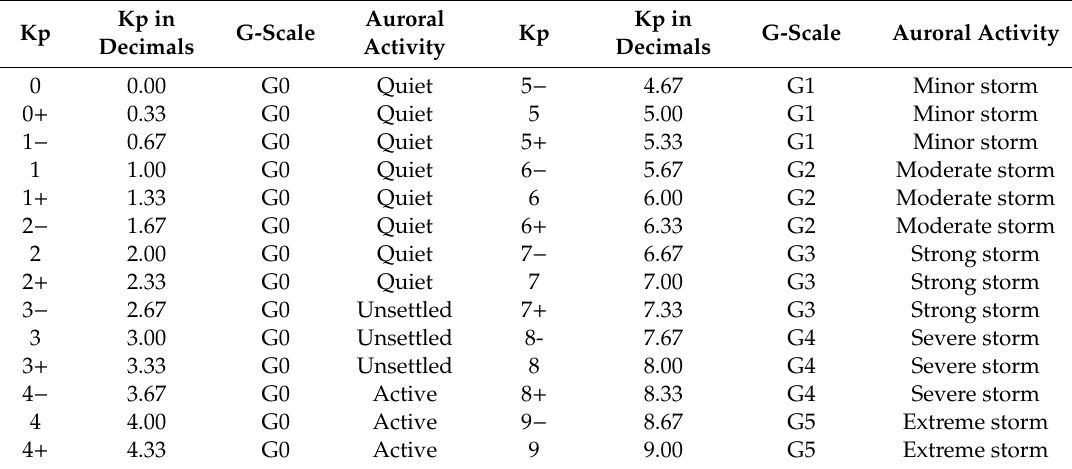
Table 1. The values of the